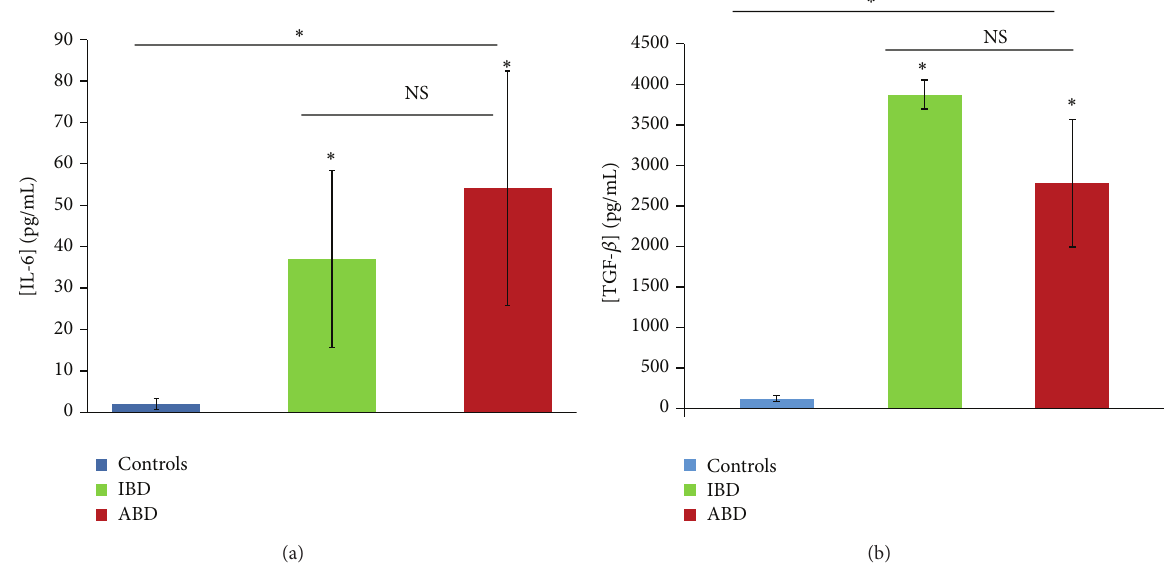
Figure 2: Plasmatic IL-6 (a) and TGF- 𝛽 (b) levels in patients with BD ( 𝑛 = 36 ) during active stage (ABD) and inactive stage (IBD) and in control subjects (controls, 𝑛 = 15 ) (ns: 𝑃 > 0.05 ; ∗ : 𝑃 < 0.05 versus control subjects).